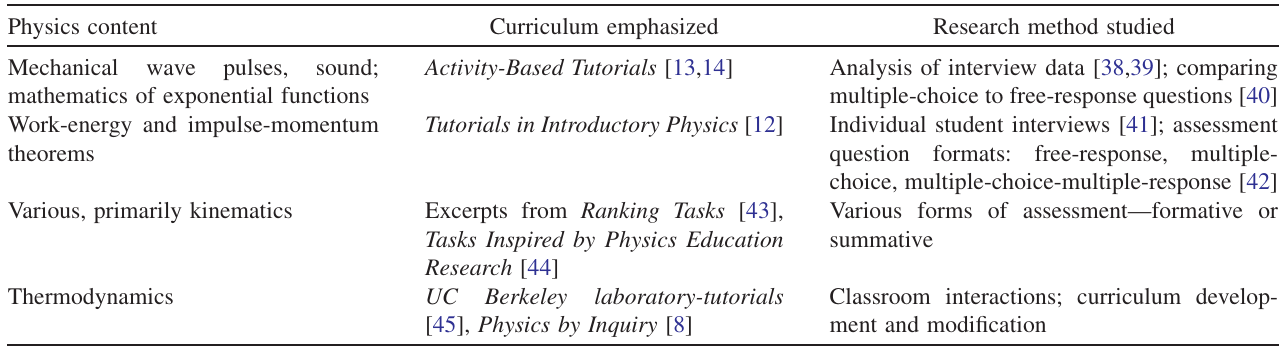
TABLE II. Course II instructional